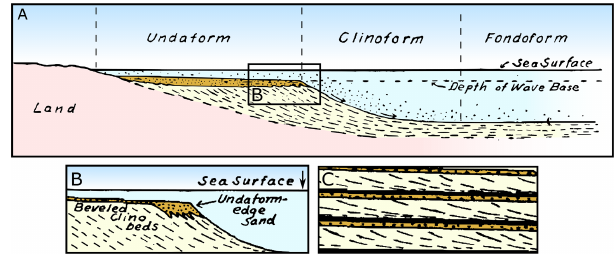
Figure 21. Sketches and terminology for coastal marine deposits (modified from Rich, 1951): (a) undaform, clinoform, fondoform. (b) Area of thick sand on the outer edge produced by the slight reduction in sea level. (c) Alternations of coastal marine deposits produced by intermittent changes in sea